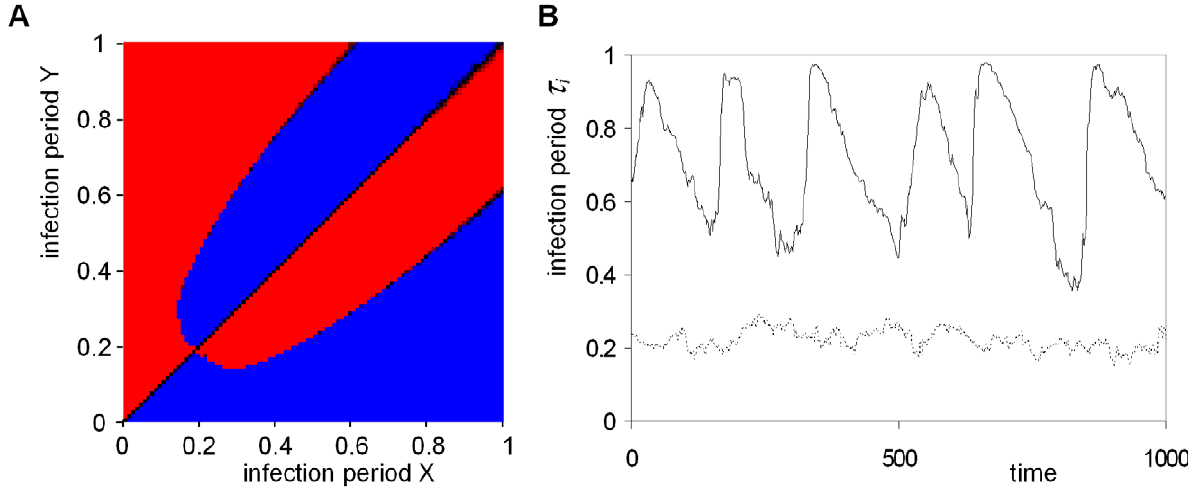
Figure 2. Evolutionary cycling in the length of infection period. A: Pair wise competition plot for infection periods. All competitions between infection periods from t I =0.01 up to t I =1 with 0.01 increment are performed using the procedure of Fig. 1 (using a 501 6 100 field size). Blue indicates that infection period X wins and red indicates that Y wins. Black cells indicate that the competition is not decided after 500 time units, and cells are dark shaded in blue or red if after this period there is one type that has a large majority. The figure is, as expected, almost completely symmetric along the diagonal. B: Attractor dynamics with small mutation rate m =0.01 (dashed line) and large mutation rate m =0.05 (solid line). Initial dynamics are omitted and only the attractor dynamics are shown for 1,000 time units. The small mutation rate converges to an attractor around t I =0.2, whereas the large mutation rate shows sustained large amplitude cycles in the length of the infection period. The average length of the infection period is plotted for a 40 6 40 subfield of a total field size of 300 6 300 cells with periodic boundary conditions. Mutation step size is D t i =0.01. Other parameters and settings are as in Fig. 1.